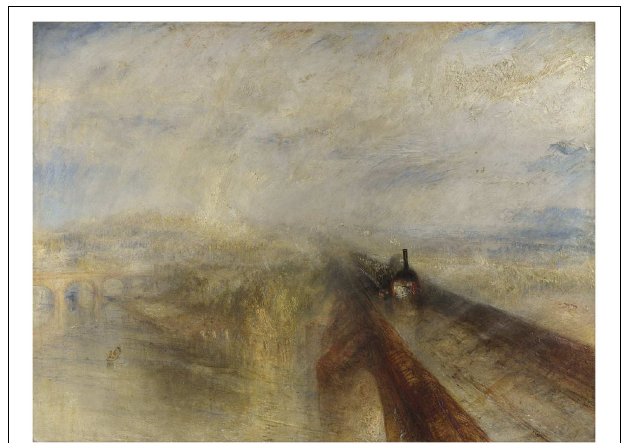
FIGURE 2 | Joseph Mallord William Turner, Rain, Steam, Speed: The Great Western Railway , 1844, Oil on Canvas, National Gallery, London. Turner Bequest, 1856. © The National Gallery, London.